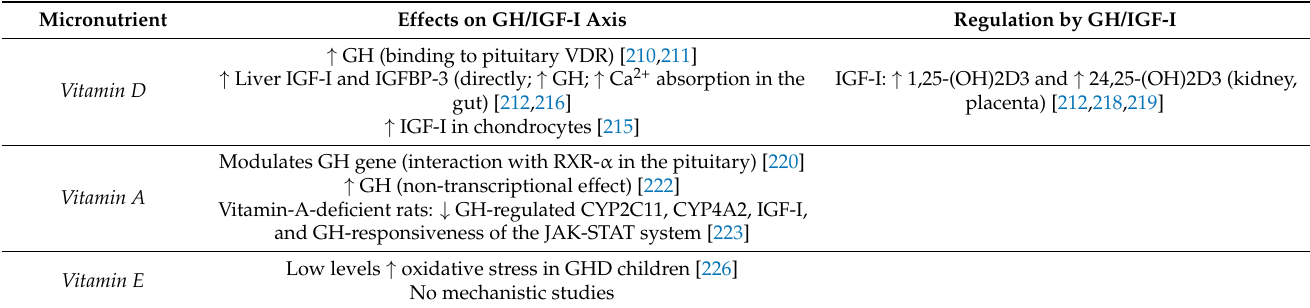
Table 2. Regulation among the GH-IGF-I axis, vitamins, and minerals ↑ = increase; ↓ = decrease; ↔ = no changes. Micronutrient Effects on GH/IGF-I Axis Regulation by